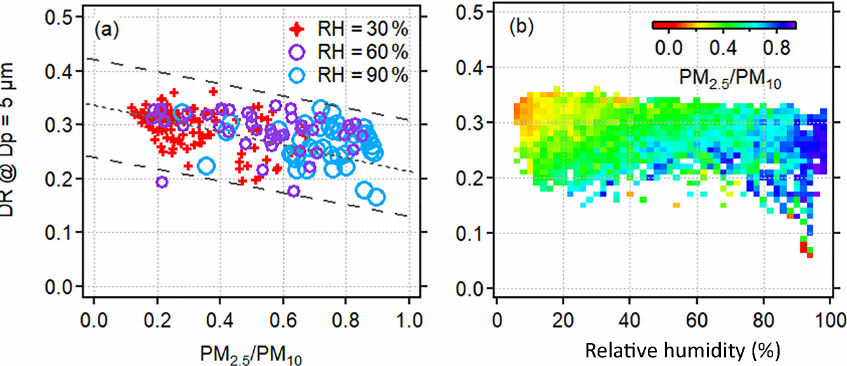
Figure 10. Scatter diagram of the relationship between the δ values of dust particles (at Dp = 5µm), vapor content (RH) and PM 2 . 5 / PM 10 in the